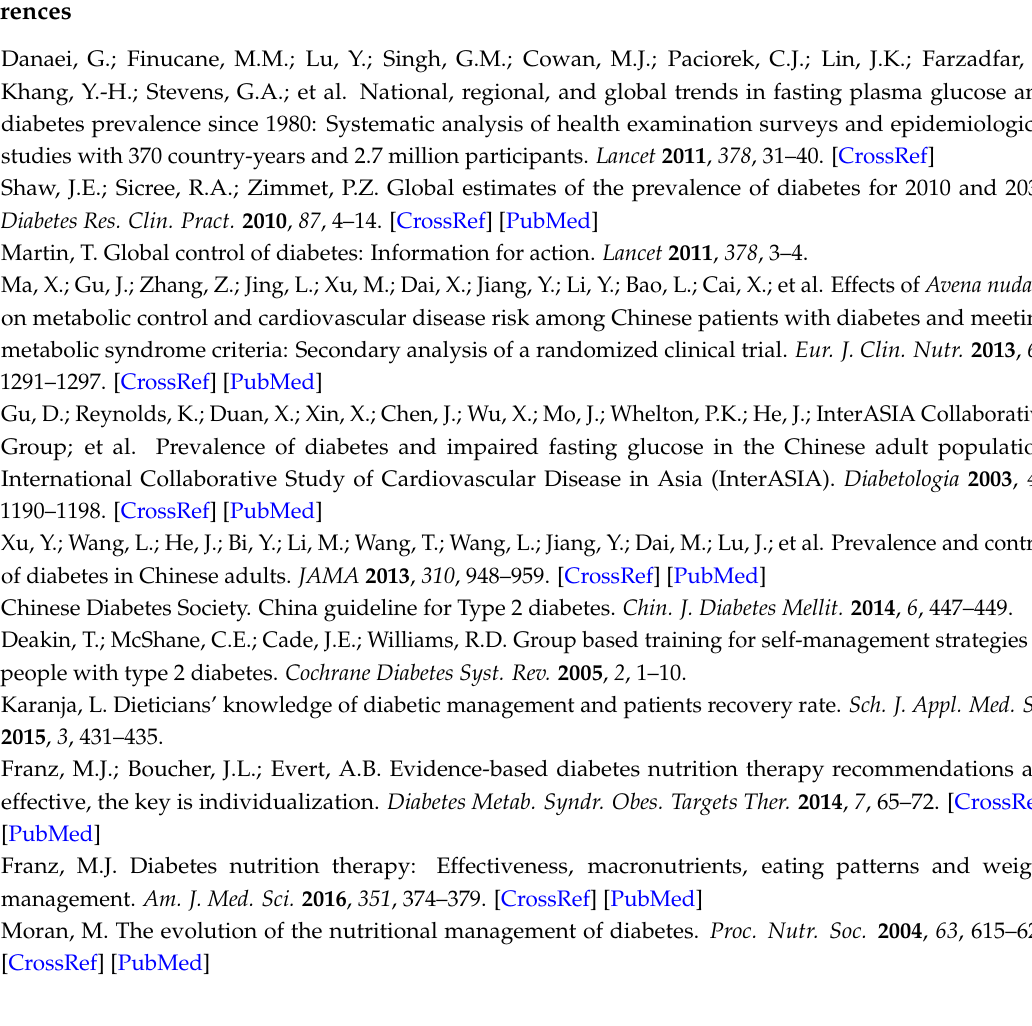
Table S1: Structured diet for a 7-day cyclical dietary menu, Table S2: The contents of the health education, Table S3: The N-DDP score